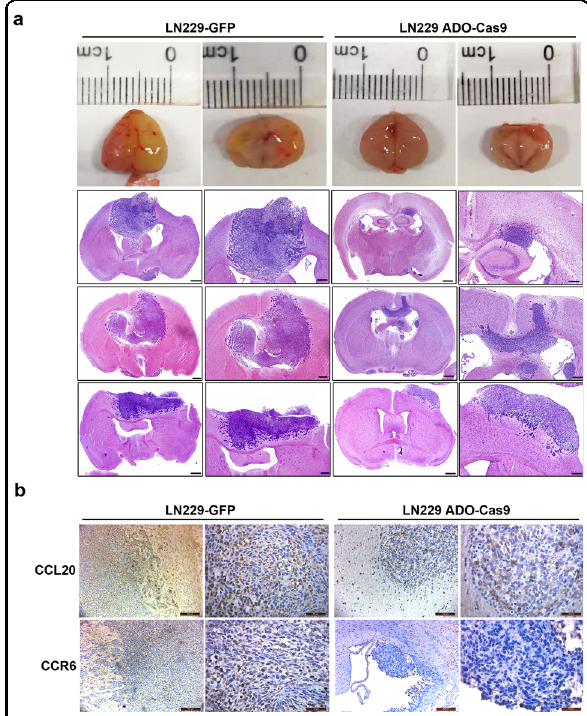
Fig. 6 Inhibiting ADO attenuates glioblastoma growth in vivo. a LN229 ADO-Cas9 and control cells were injected into an orthotopical mouse xenograft model to analyze for in vivo tumor growth. Scale bars = 100 μ m and 500 μ m. b CCL20 and CCR6 expression were evaluated by immunohistochemistry in the xenograft tumors. Scale bars = 50 μ m and 200 μ m. Data represent three independent experiments with similar